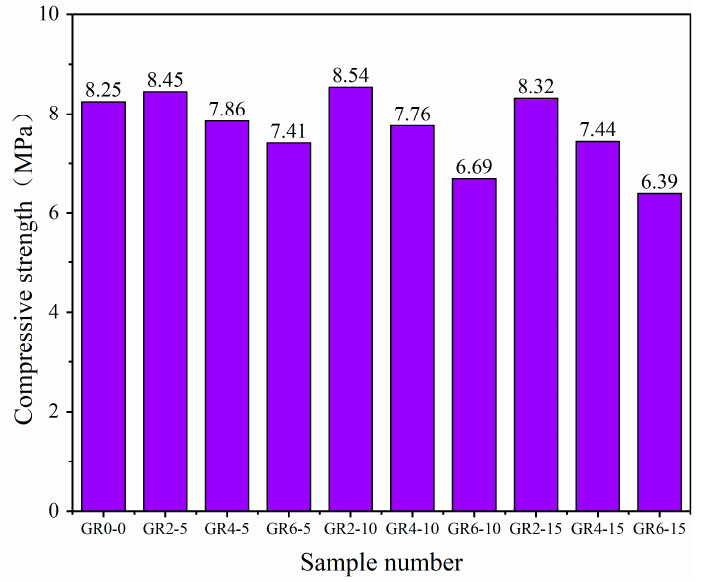
Figure 10. Compressive strength of various types of mortar on the twenty-eighth day.